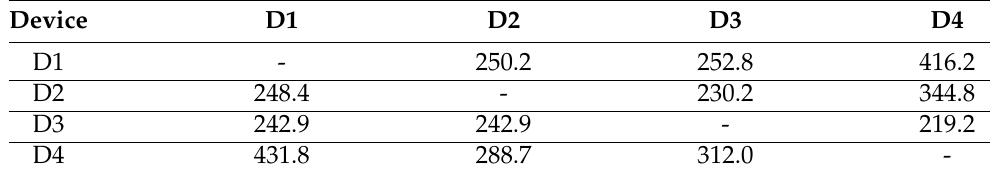
Table 1. Distance measurement results using LoRa SX1280 2.4 GHz.